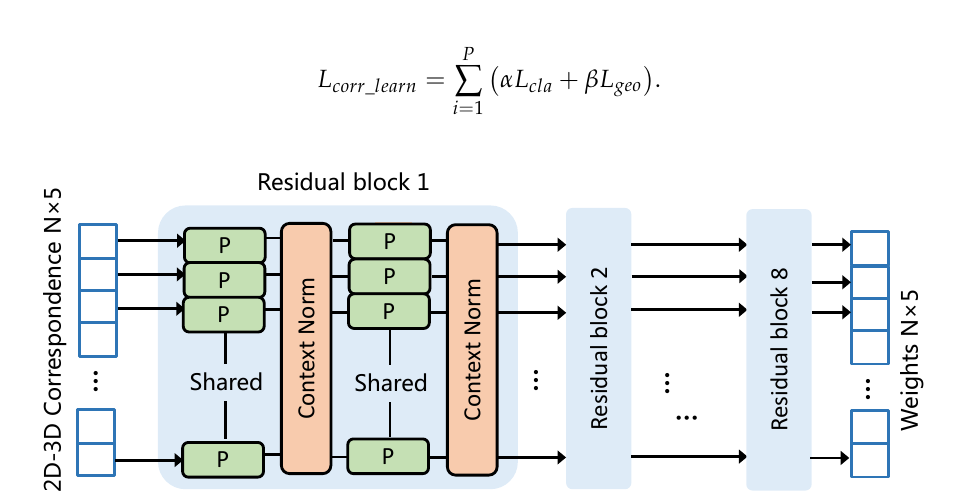
Figure 3. Architecture of the correspondence–evaluation network. It takes 2D–3D correspondences as input and produces directly correspondence weights. The basic residual block consisting of weight-sharing perceptrons and context normalization. In practice, the multi-layer perceptrons are implemented using conv 1 d in tensorflow